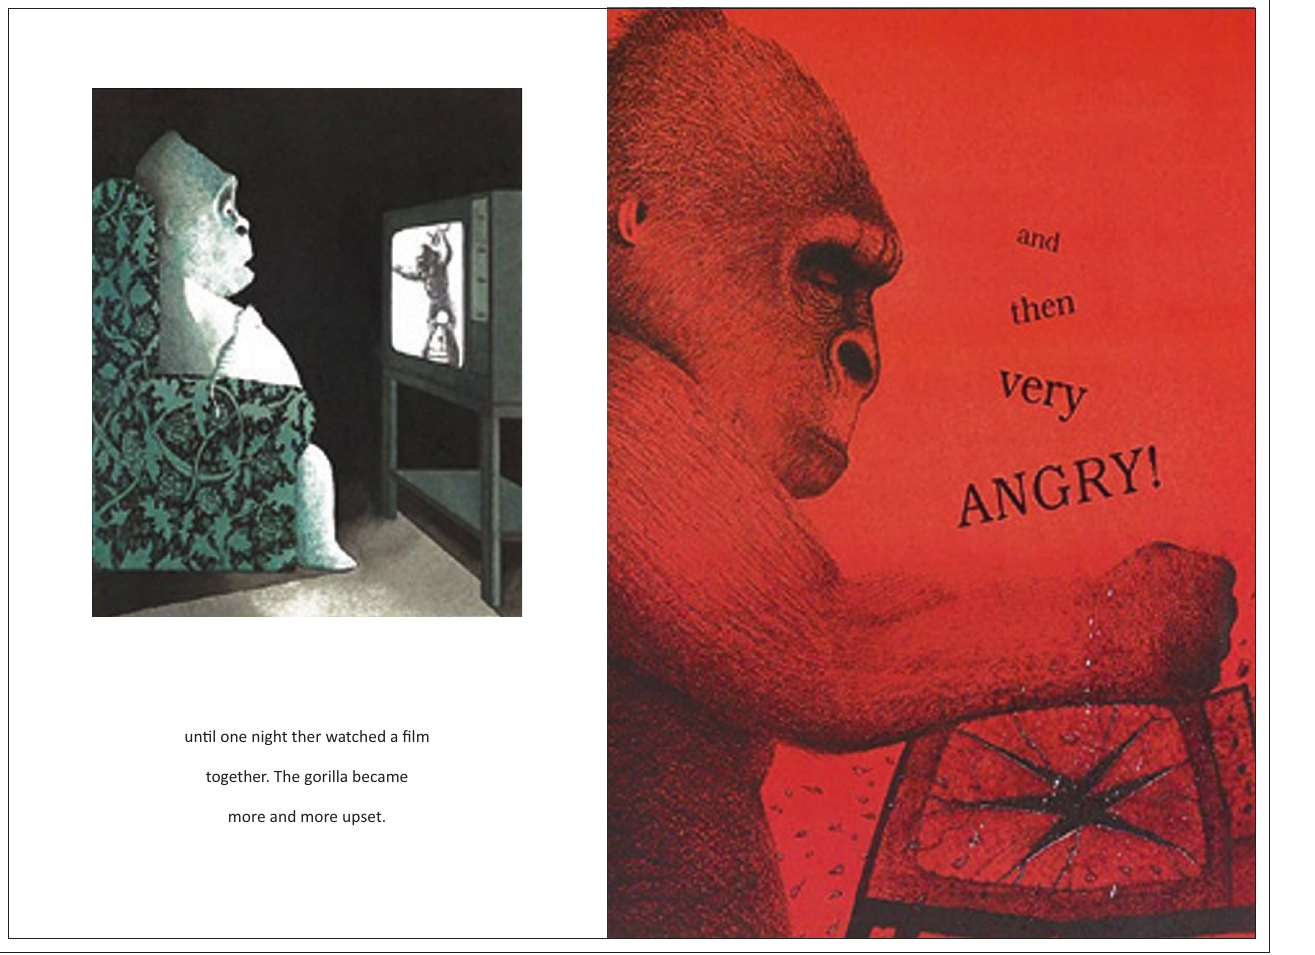
FIGURE 3: The gorilla became very